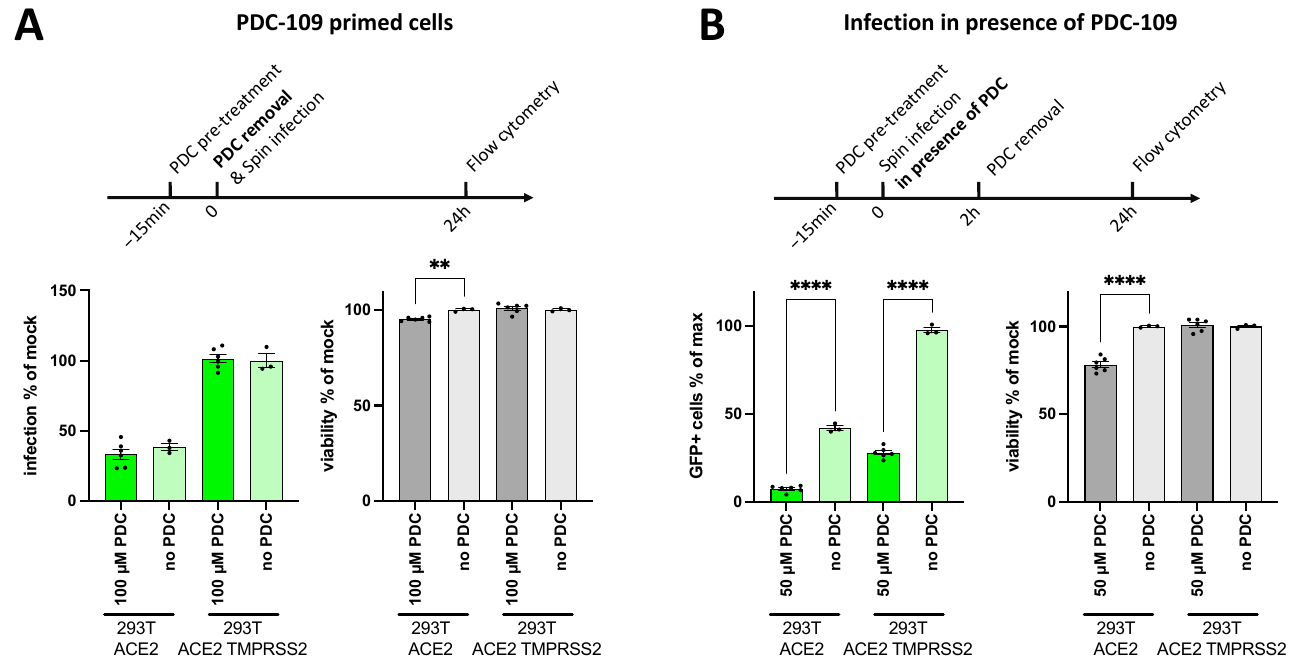
Figure 3. Permissivity of PDC-109 pre-treated cells. ( A ) 293T ACE2 and 293T ACE2 TMPRSS2 cells were pre-treated with 100 µ M PDC-109 for 15 min and spin-infected with CoV-2 spike pseudoviruses in absence of PDC. ( B ) 293T ACE2 and 293T ACE2 TMPRSS2 cells were pre-treated with 50 µ M PDC-109 for 15 min and spin-infected with CoV-2 spike pseudoviruses in presence of PDC for 30 min, followed by 90 min incubation at 37 ◦ C. Subsequently, cells were washed and cultured further. Reporter virus signal and cell viability were assessed by flow cytometry at 24 h p.i. Frequencies of GFP+ cells are shown as a measure of VSV*SARS CoV-2 infection and were normalized to mock- treated samples (0 µ M). Significance was assessed by parametric one-way analysis of variance (ANOVA) tests, comparing all samples with their respective mock control (no PDC) and displayed as follows: **** p < 0.0001; *** p < 0.001; ** p = 0.001–0.01; * p =